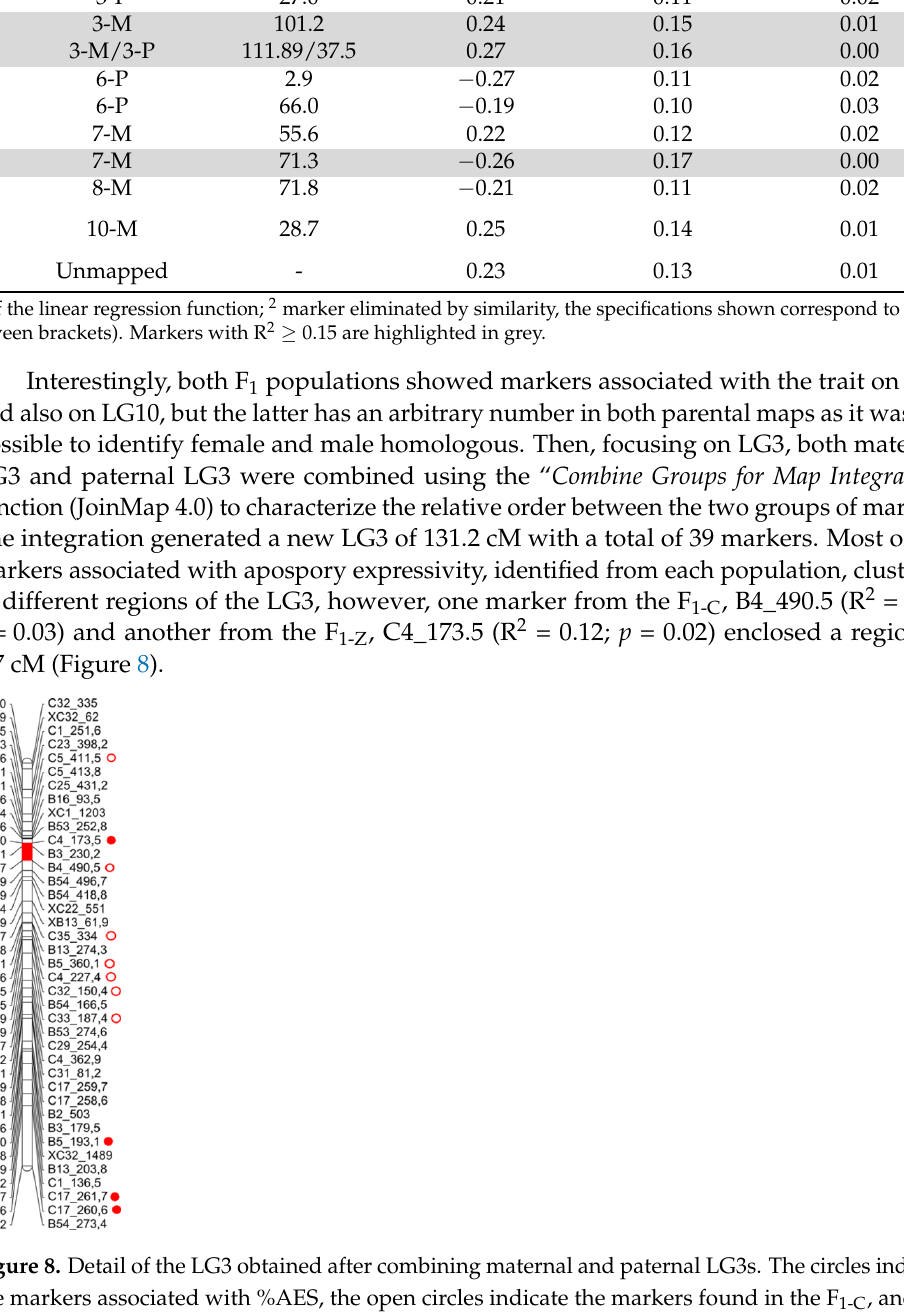
Table 7. Markers significantly associated with apospory expressivity detected in the F 1-Z population .